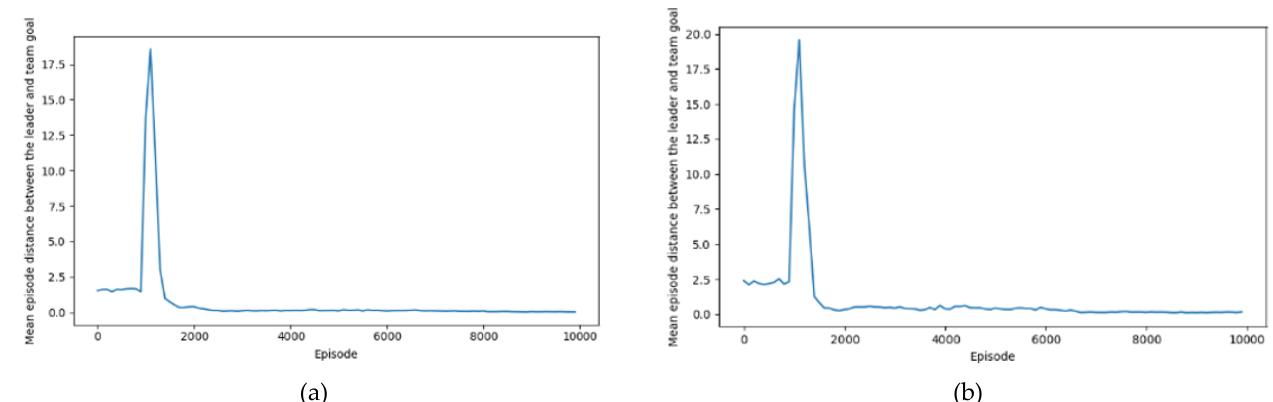
Figure 7. The reward of multiple cooperative USVs with formation generation policies for 40,000 episodes with different numbers of USVs: ( a ) mean episode reward for 3 USVs during formation generation policies training over 10,000 episodes; ( b ) mean episode reward for 5 USVs during formation generation policies training over 20,000 episodes; ( c ) mean episode reward for 7 USVs during formation generation policies training over 10,000 episodes.